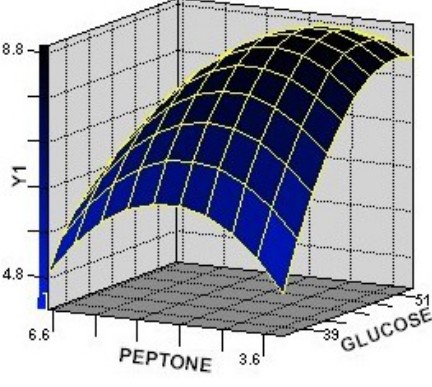
Figure 2. The surface plot of the combined effects of glucose and culture time on Y (GA-Me) production by G. lucidum . Fixed level: peptone concentration = 0 (coded value).